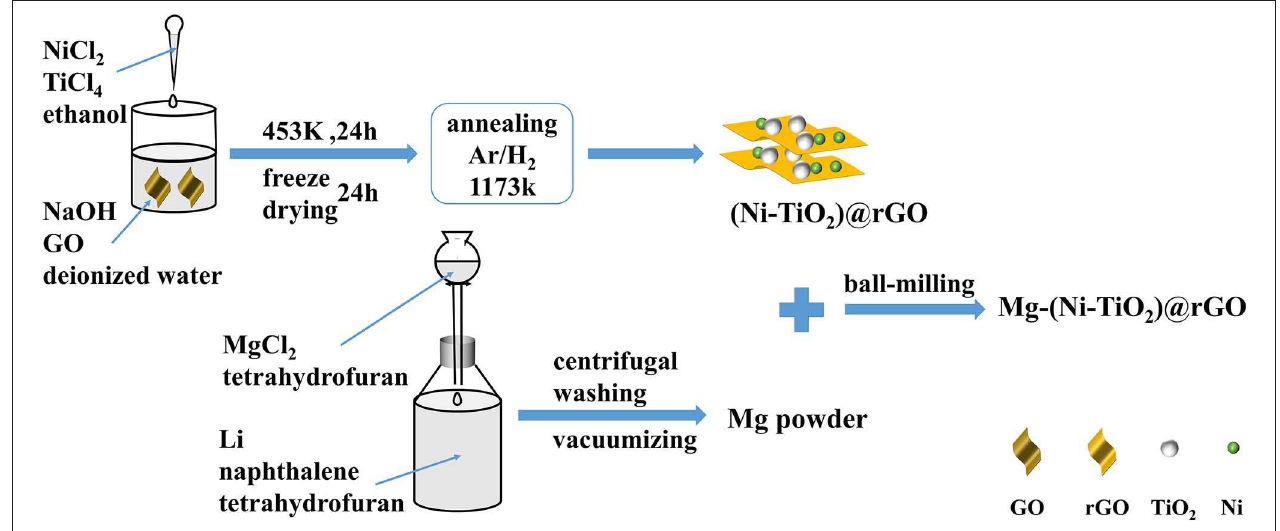
FIGURE 1 | Schematic preparation of (Ni-TiO 2 )@rGO composite.